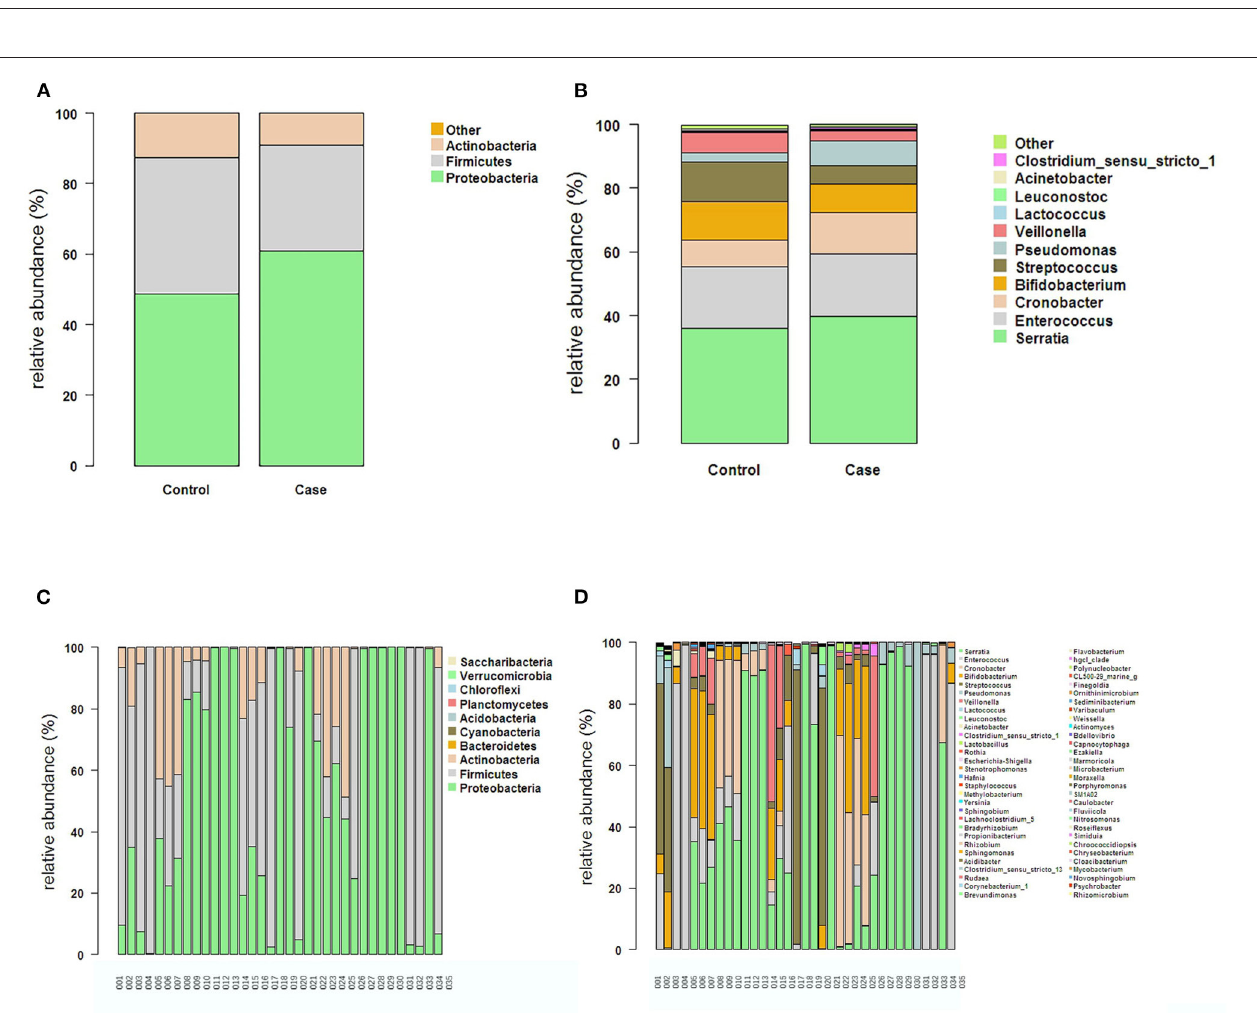
Frontiers in Pediatrics |